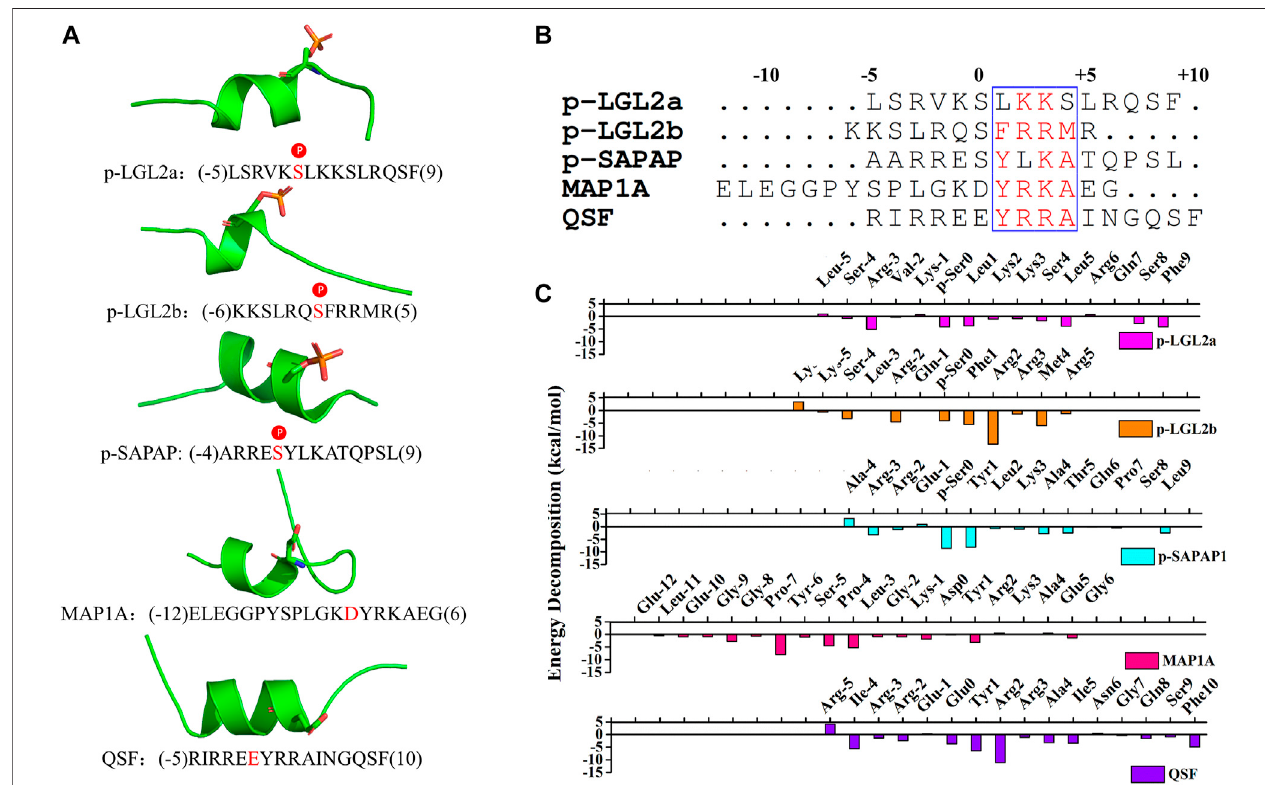
FIGURE 1 | (A) Crystal structures of the peptides (p-LGL2a, p-LGL2b, p-SAPAP1, MAP1A, and QSF). The p-Ser or Asp/Glu were displayed in sticks. (B) Amino acid sequence alignment of the peptides using Clustal W. Highly conserved residues (conservation score > 0.7) were framed in blue according to